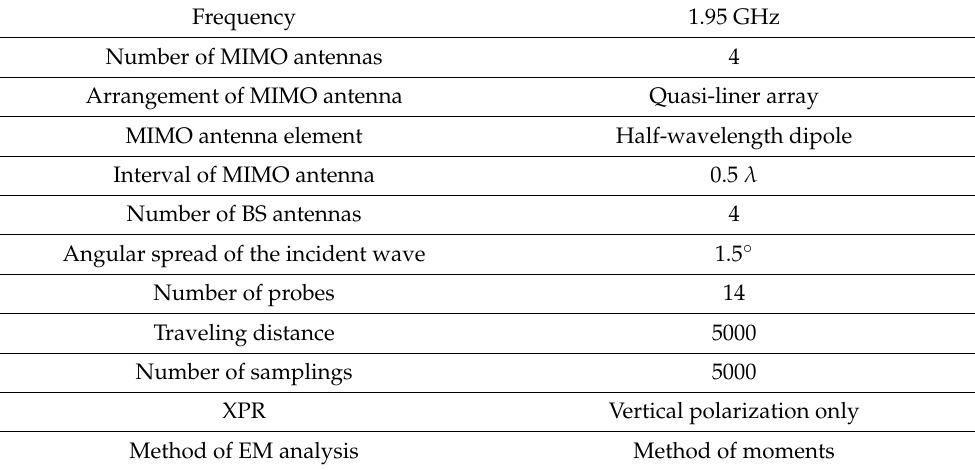
Table 2. Measurement and analytical